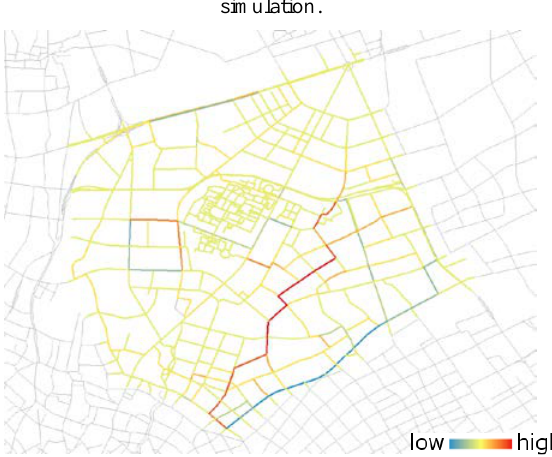
Figure 15. Difference simulated betweenness value between before and after the integration of interior roads into public road